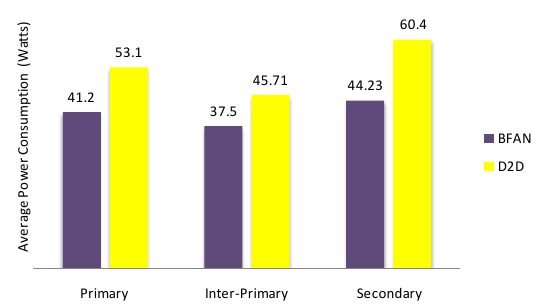
Figure 6. Average power consumption of proposed BFAN and D2D platforms.